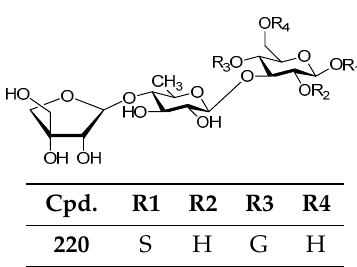
Figure 37. Structure of compound 220 .